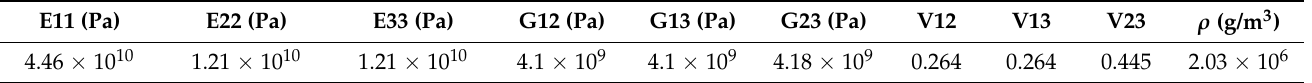
Table 2. Orthotropic material properties for glass/polyester.